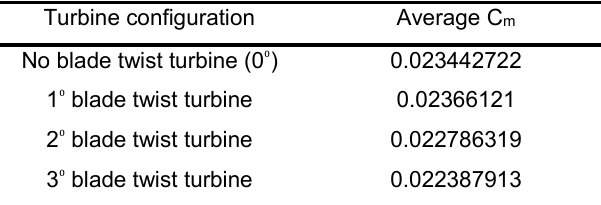
Table 3. Details of average moment coefficient (C m ) for different turbine